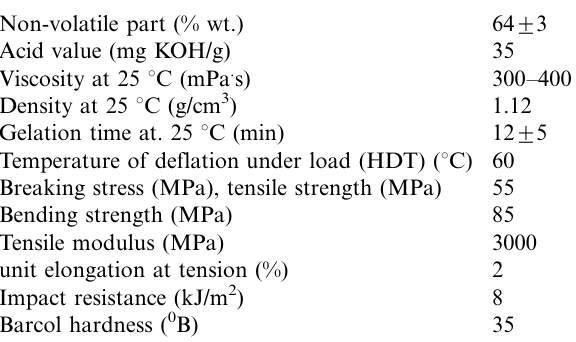
Table 1. Parameters of Polimal 1033 APy PES Non-volatile part (%